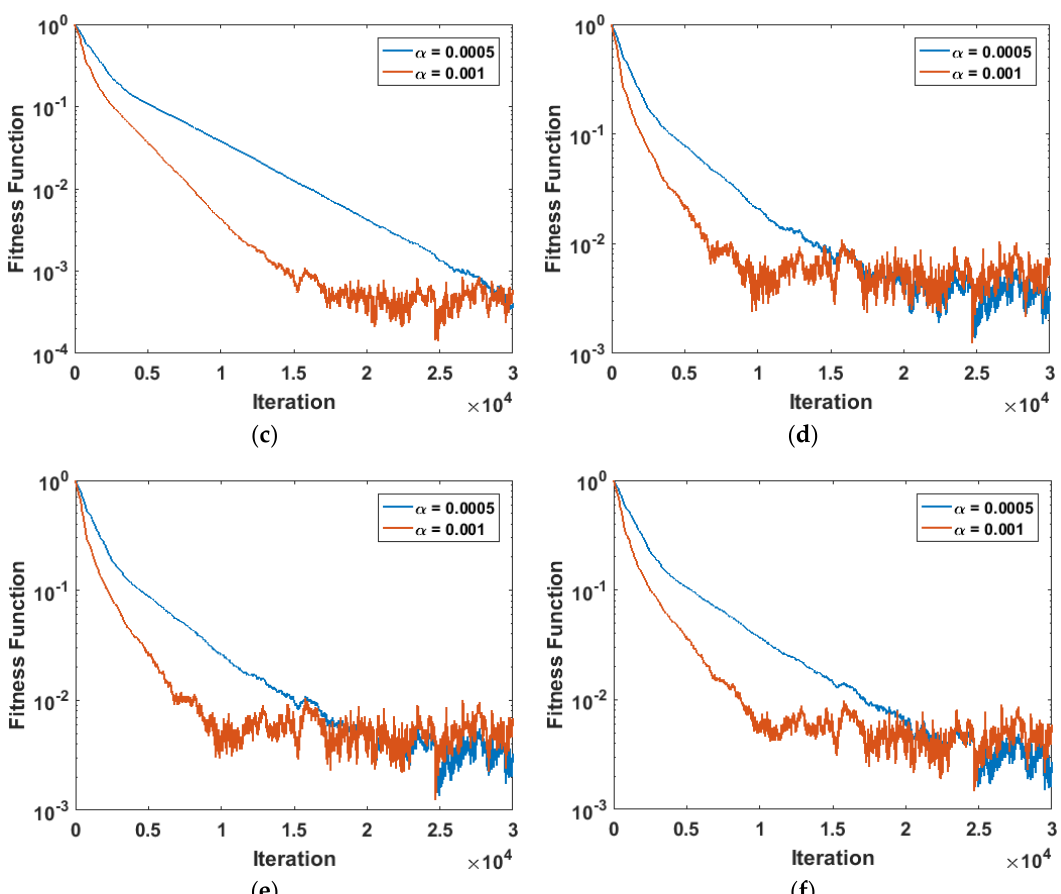
Figure 2. Learning curves of the HQFGD for different step size variations. ( a ) µ = 0.8, σ = 0.02; ( b ) µ = 1, σ = 0.02; ( c ) µ = 1.2, σ = 0.02; ( d ) µ = 0.8, σ = 0.2; ( e ) µ = 1, σ = 0.2; ( f ) µ = 1.2, σ = 0.2.